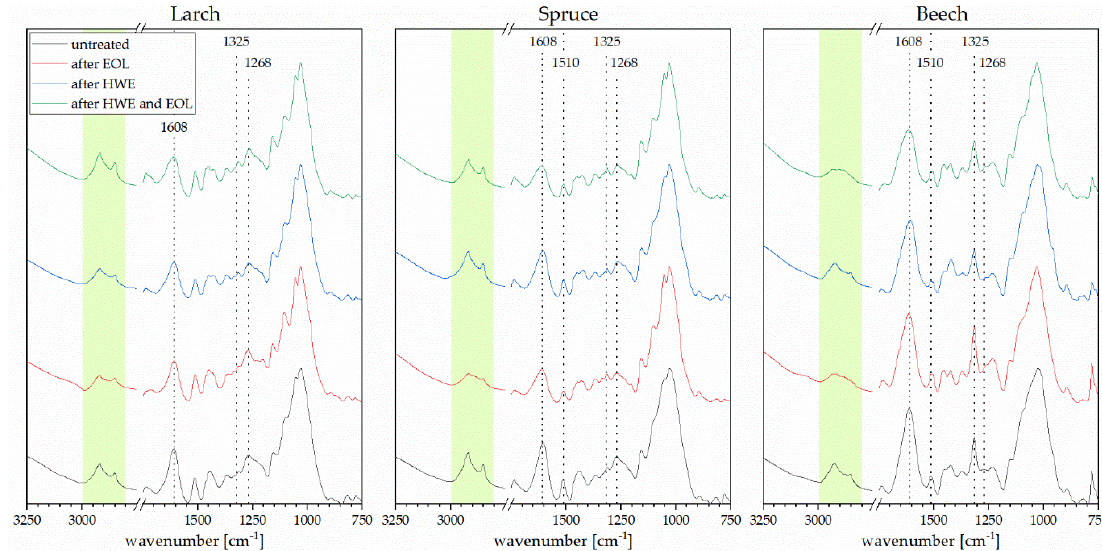
Figure 4. FTIR spectra of unmodified bark and bark after treatment.